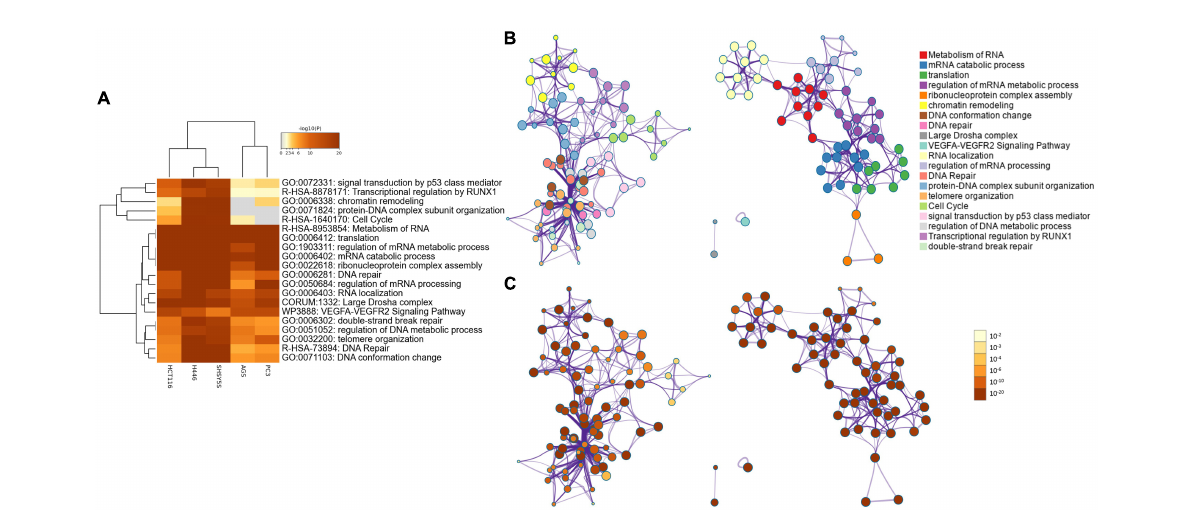
FIGURE2 (A) Heatmap showing the top 20 enrichment terms across input proteins in the five cell lines, according to the p -value. (B) Network of enriched ontology clusters colored by cluster ID. A subset of enriched terms was selected based on the best p-values from each of the 20 clusters, and represented as a network plot, visualized by Cytoscape (Shannon et al., 2003). Each node represents an enriched term and is colored by its cluster ID. The 20 cluster IDs are listed on the side. (C) Network of enriched ontology clusters colored by p -value. The same network shown in (B) is represented colored by its p-value. On the side is the p -value scale ranging from 10 − 2 to 10 − 20 .